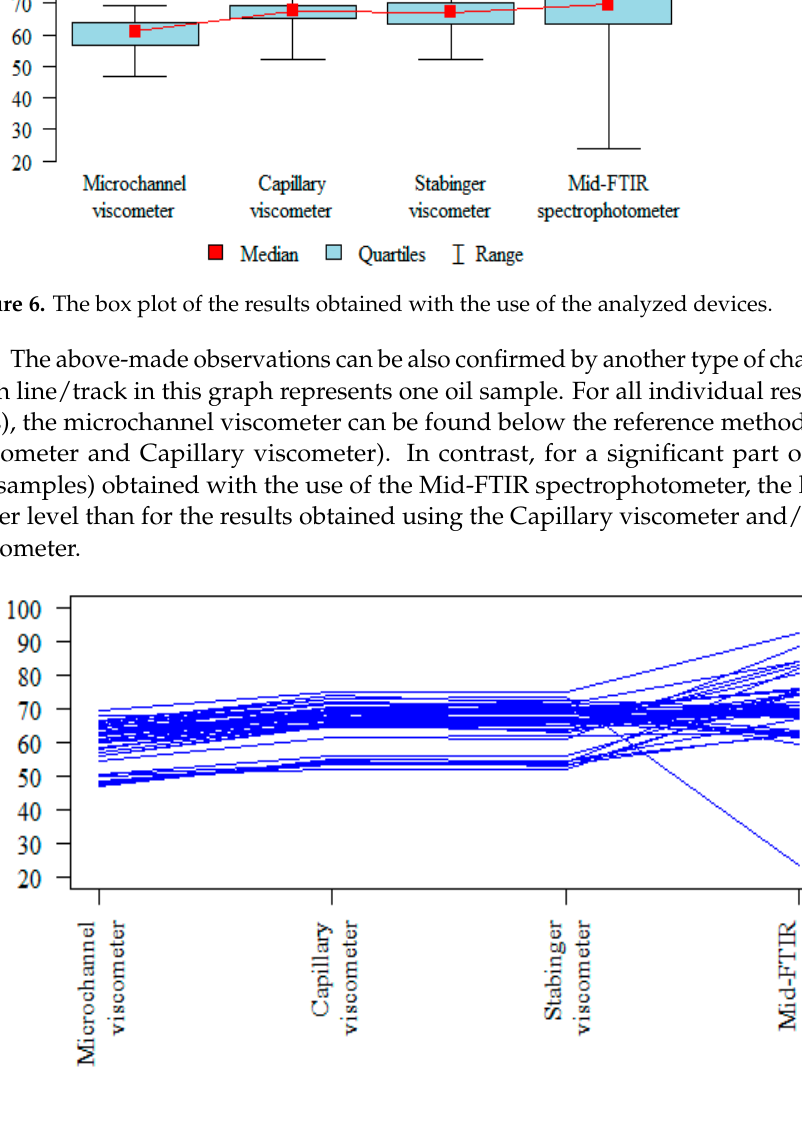
Figure 7. The tracks of the results for individual oil samples.